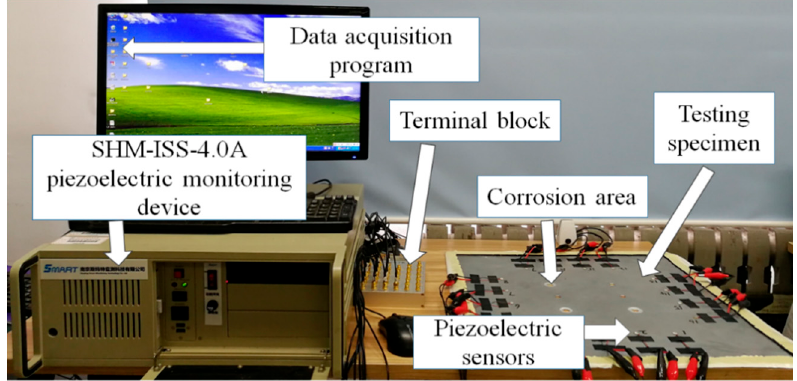
Figure 7. The experimental device.